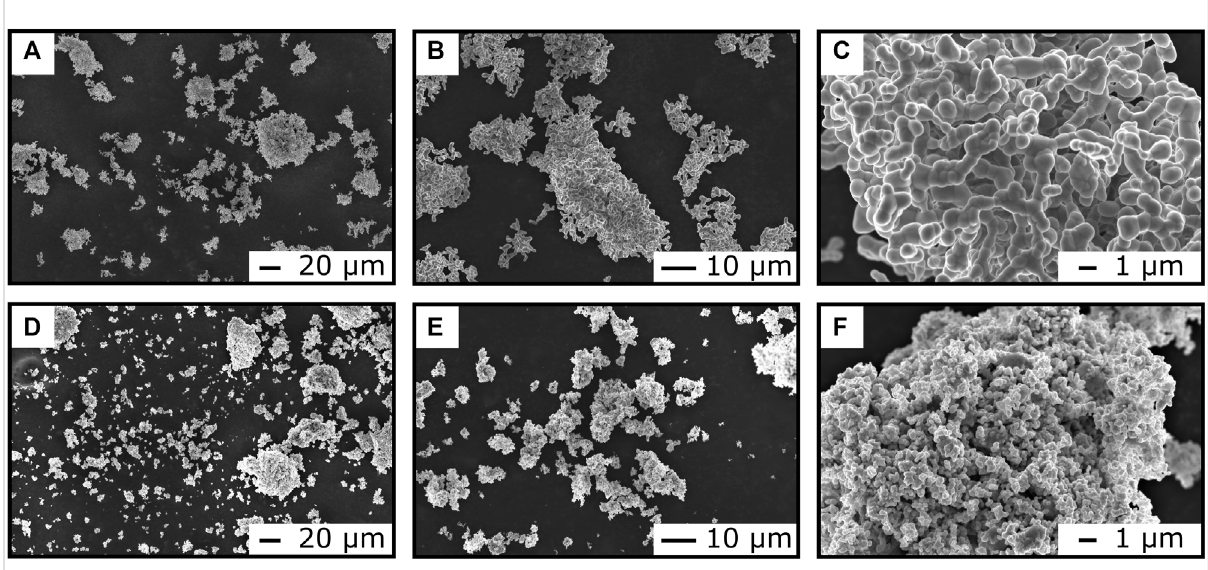
FIGURE 4 Top-view SEM images at different magni fi cations of HEO-La (A – C) and HEO-Sr (D – F) prepared using Pechini method. Both materials were calcined at 1,200 ° C and for 12 h.